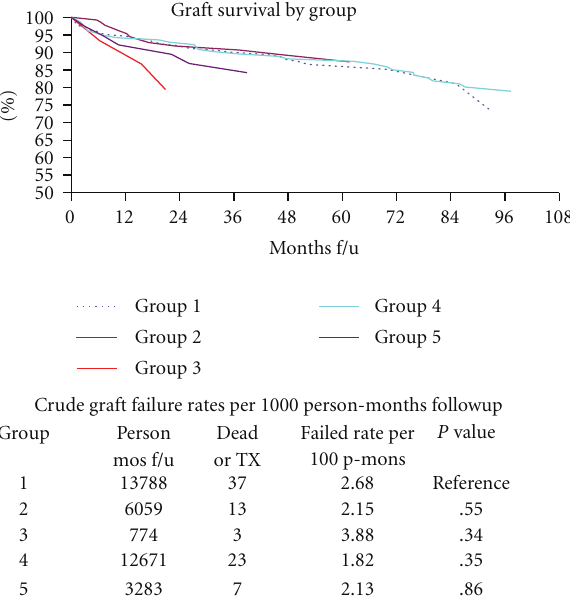
Figure 1: Graft survival by group. It depicts plots and tables of graft survival across the five groups represented by failure rates per 1000 person-months followup. Table 3: Steroid-resistant rejection rates per 1000 person-months. Group Person mos f/u Rate per 1000 p-mon